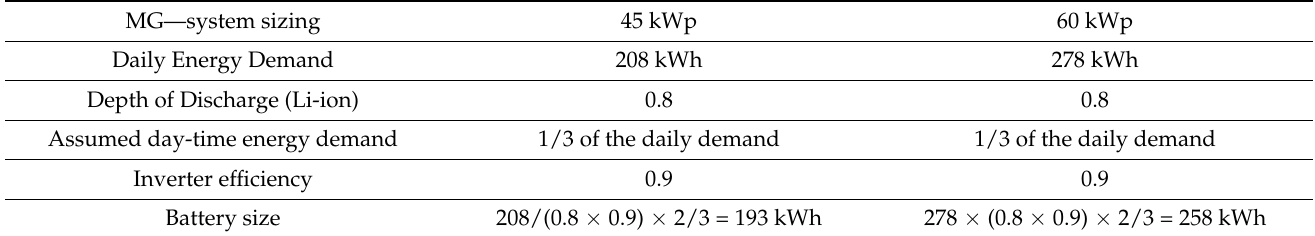
Table A5. Mpanta—Optimised battery-sizing scenario.